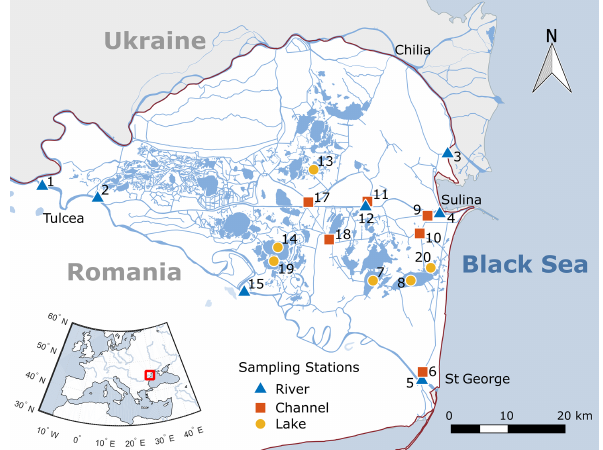
Figure 1. Sampling stations in the Danube Delta, Romania. Near Tulcea, the Danube River splits into three branches, namely Chilia, Sulina and St George. Station 16 was removed from the study because of limited access during lower water level (clogged ac- cess channel). Shape files for map creation in QGIS are adapted from https://mapcruzin.com/ (last access: 13 December 2016). Con- tains information from https://www.openstreetmap.org/, which is made available under the Open Database License (ODbL) at https: